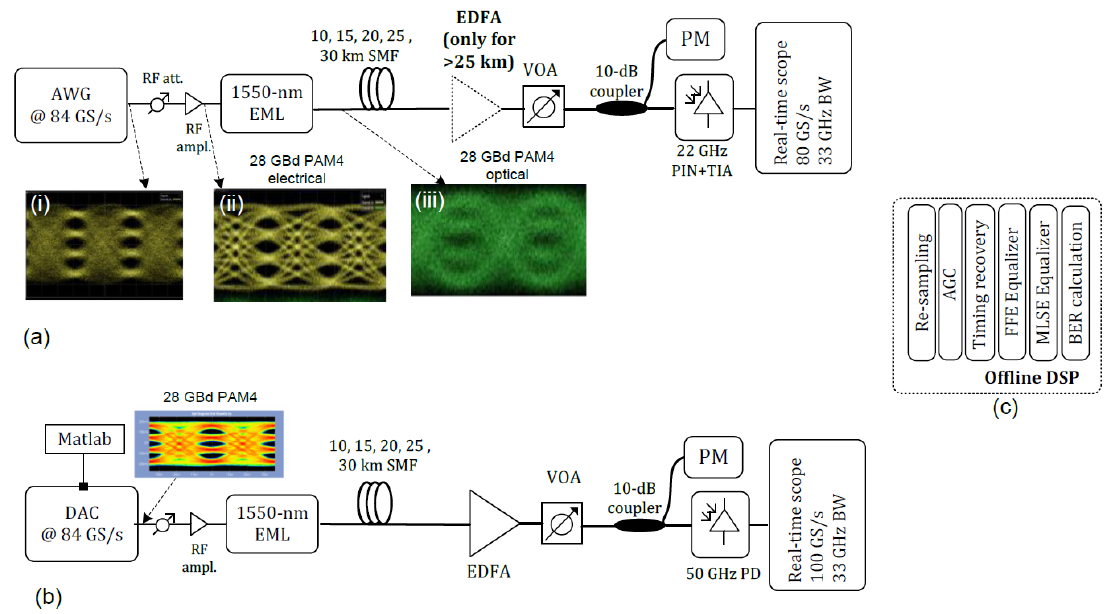
Figure 1. ( a ): Experimental setup using a 30-GHz arbitrary waveform generator (AWG); ( b ) Experimental setup using a 15-GHz digital–analog converter (DAC) [15]; ( c ): Digital signal processing (DSP) algorithms used for offline processing for both implementations.